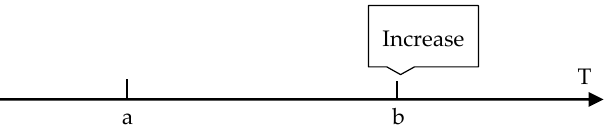
Figure 5. Example for inc : a and b represent the date of the OPEC announcement. Table 2. Description of variables.